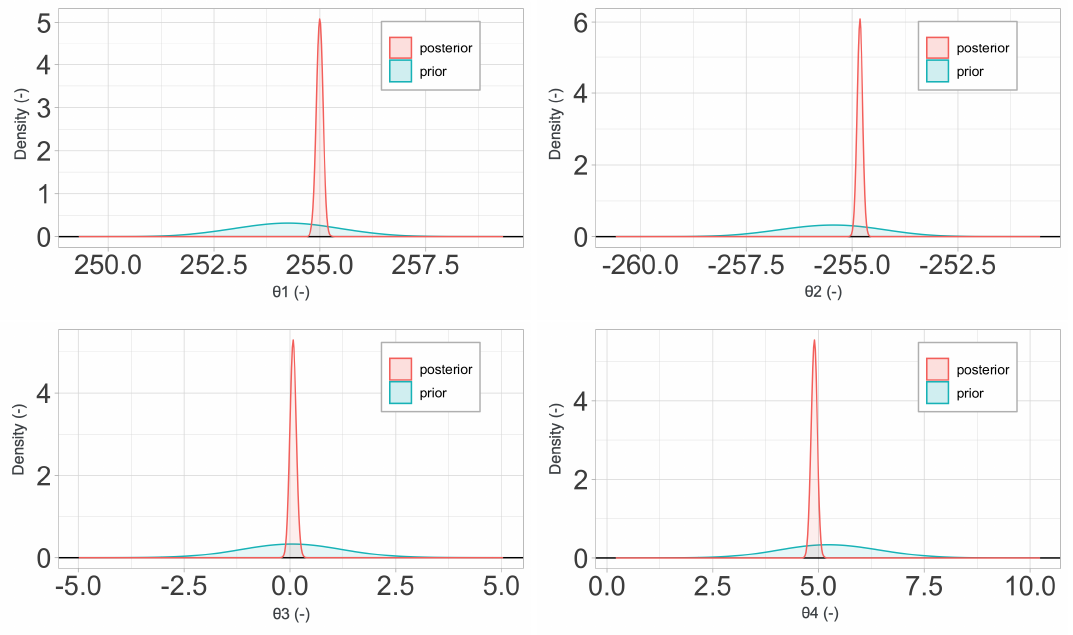
Figure 17. Prior vs. posterior parameter probability distributions for parameters A 2 ∼ θ 1 , A 3 ∼ θ 2 , α 3 ∼ θ 3 , n ∼ θ 4 of the Arrhenius-type model considering ∆ R as the